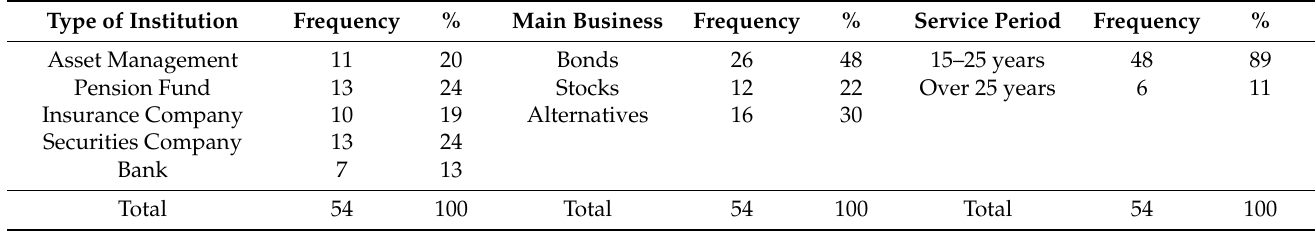
Table 3. Demographic information of valid survey